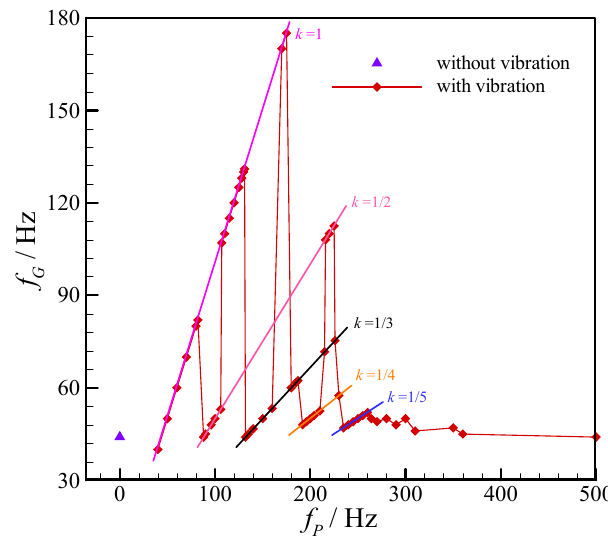
Figure 4. Variation of droplet generation frequency with external vibration frequency in the flow-focusing microfluidic device. ( Q c = 90 µ L / h, Q d = 60 µ L / h, and a m = 60 m / s 2 .).